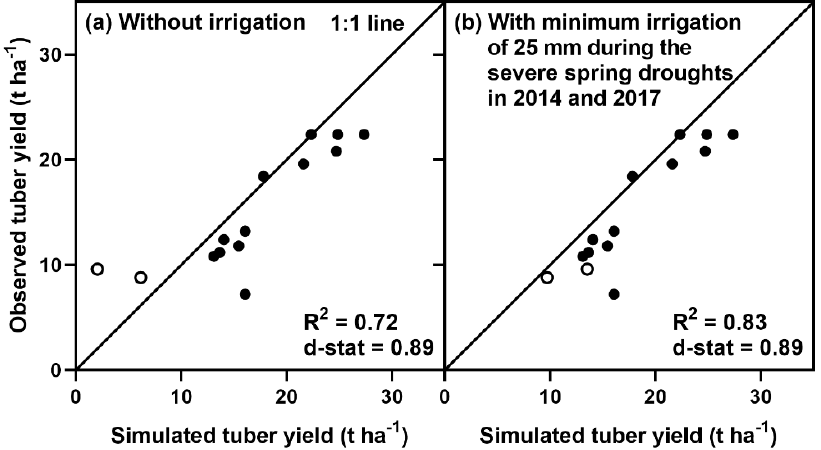
Figure 3. Model performance for potato yield in North Korea without irrigation ( a ) and with minimum irrigation of 25 mm ( b ) during the severe spring droughts in 2014 and 2017. White circles indicate the early-season potato yields in 2014 and 2017.